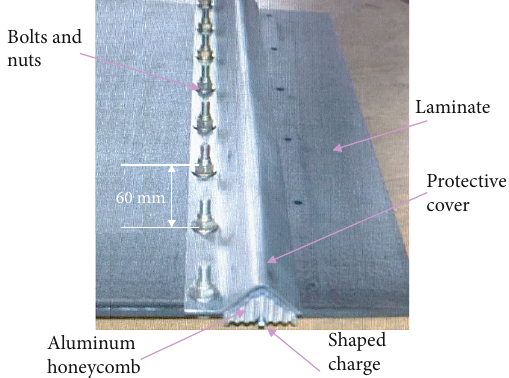
Figure 2: Cutting test of the composites separation